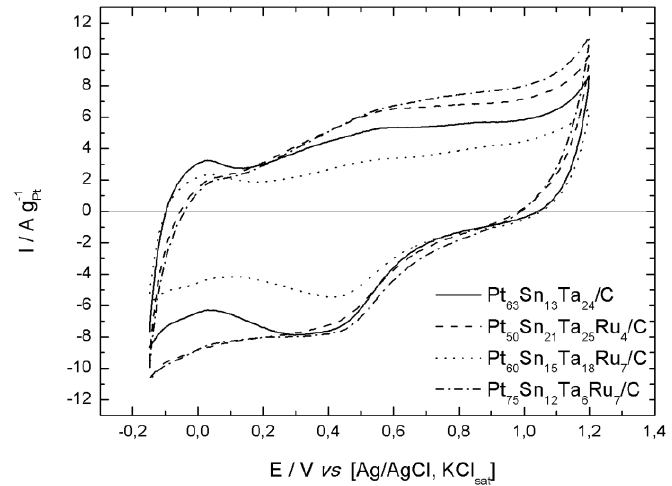
Figure 3. Cyclic voltammograms from PtSn/C catalysts modified with Ta and Ru, supported on Vulcan XC72 carbon, in supporting electrolyte (H 2 SO 4 0.5 mol L − 1 ) with a scan rate of 20 mV s − 1 (normalized current by the mass of Pt in grams).